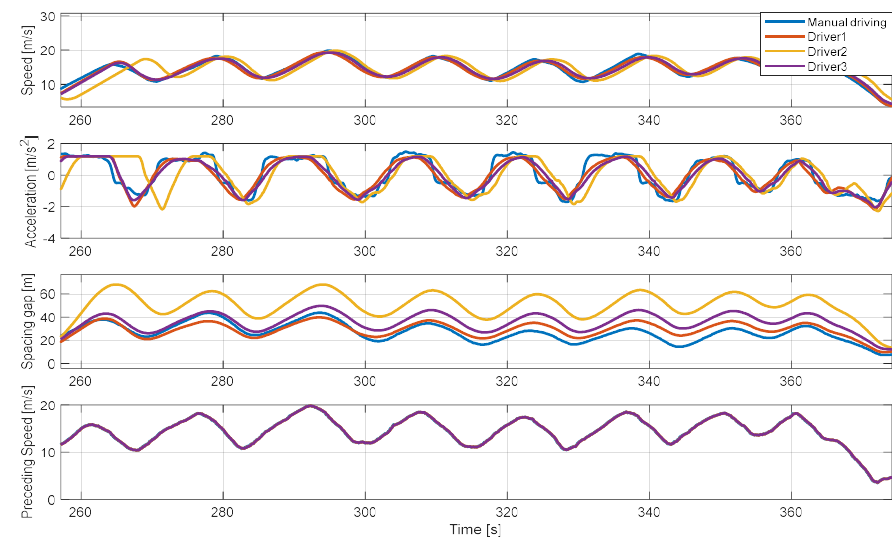
Figure 14. Driving behaviors of each driver model for identical preceding vehicle’s behavior.